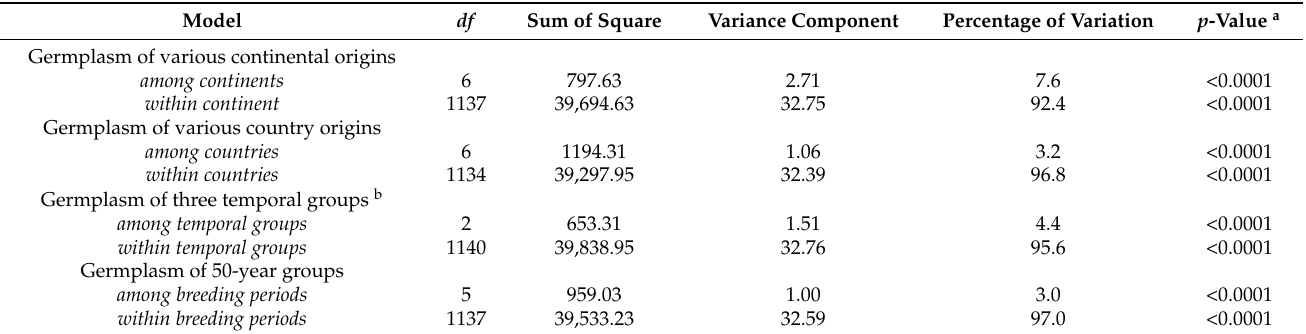
Table 3. Results of analyses of molecular variance (AMOVA) for the germplasm of 1219 potato accessions with four models of genetic